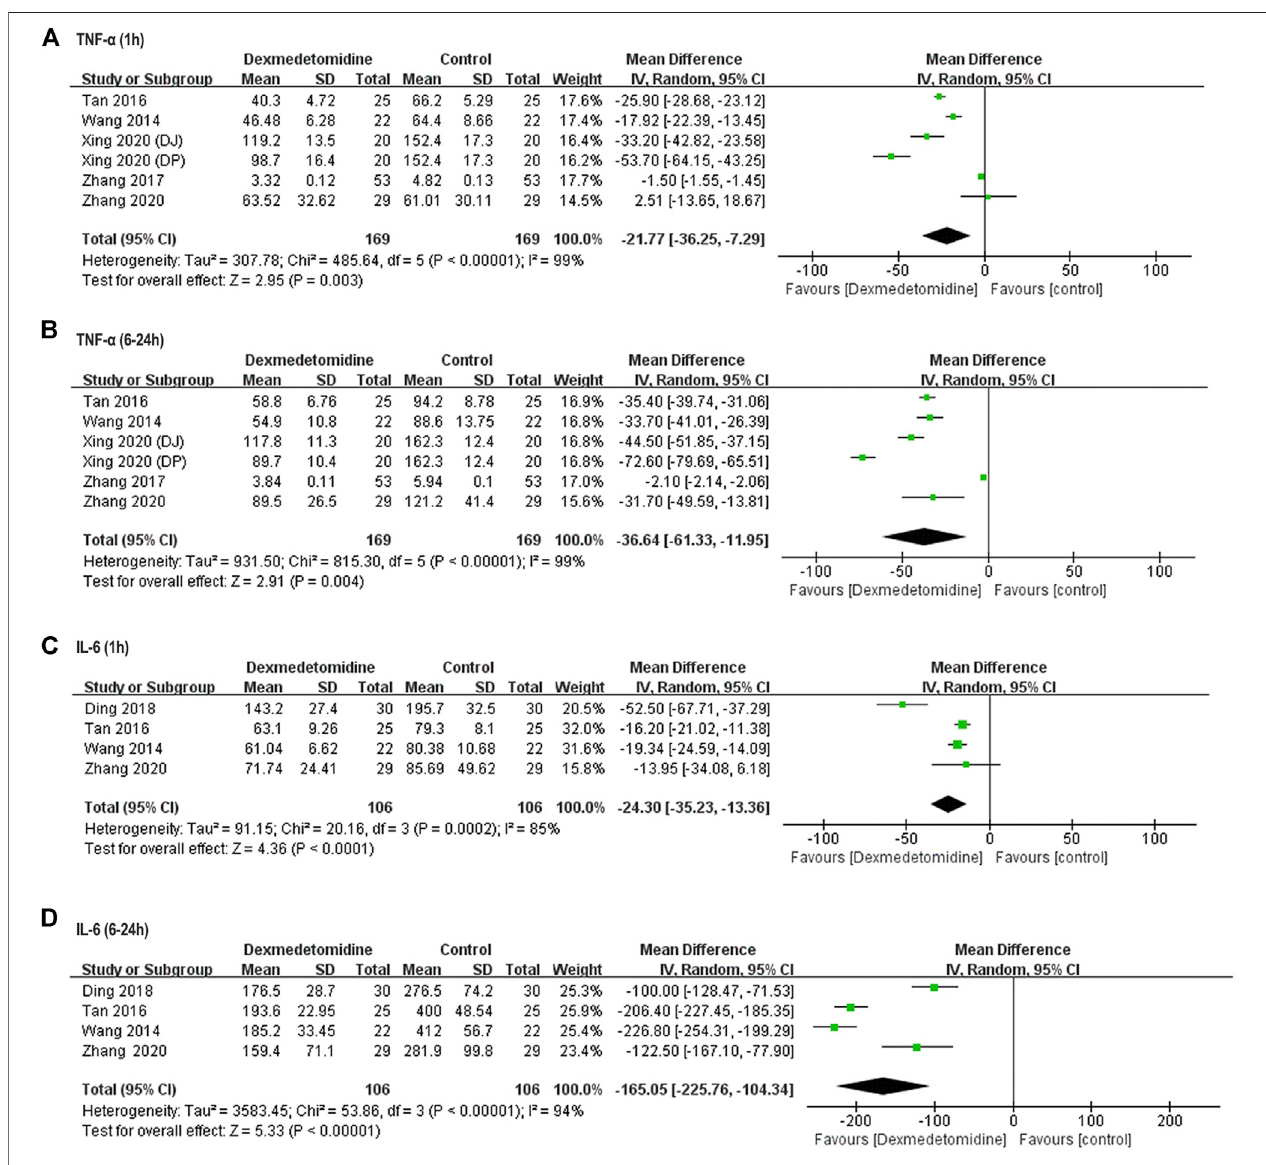
FIGURE 4 | Forest plots for meta-analyses comparing postoperative biomarkers of the in fl ammatory response between dexmedetomidine and control group of participants undergoing hepatectomy. (A) TNF- α (1 h after surgery); (B) TNF- α (6 – 24 h after surgery); (C) IL-6 (1 h after surgery); (D) IL-6 (6 – 24 h after surgery).